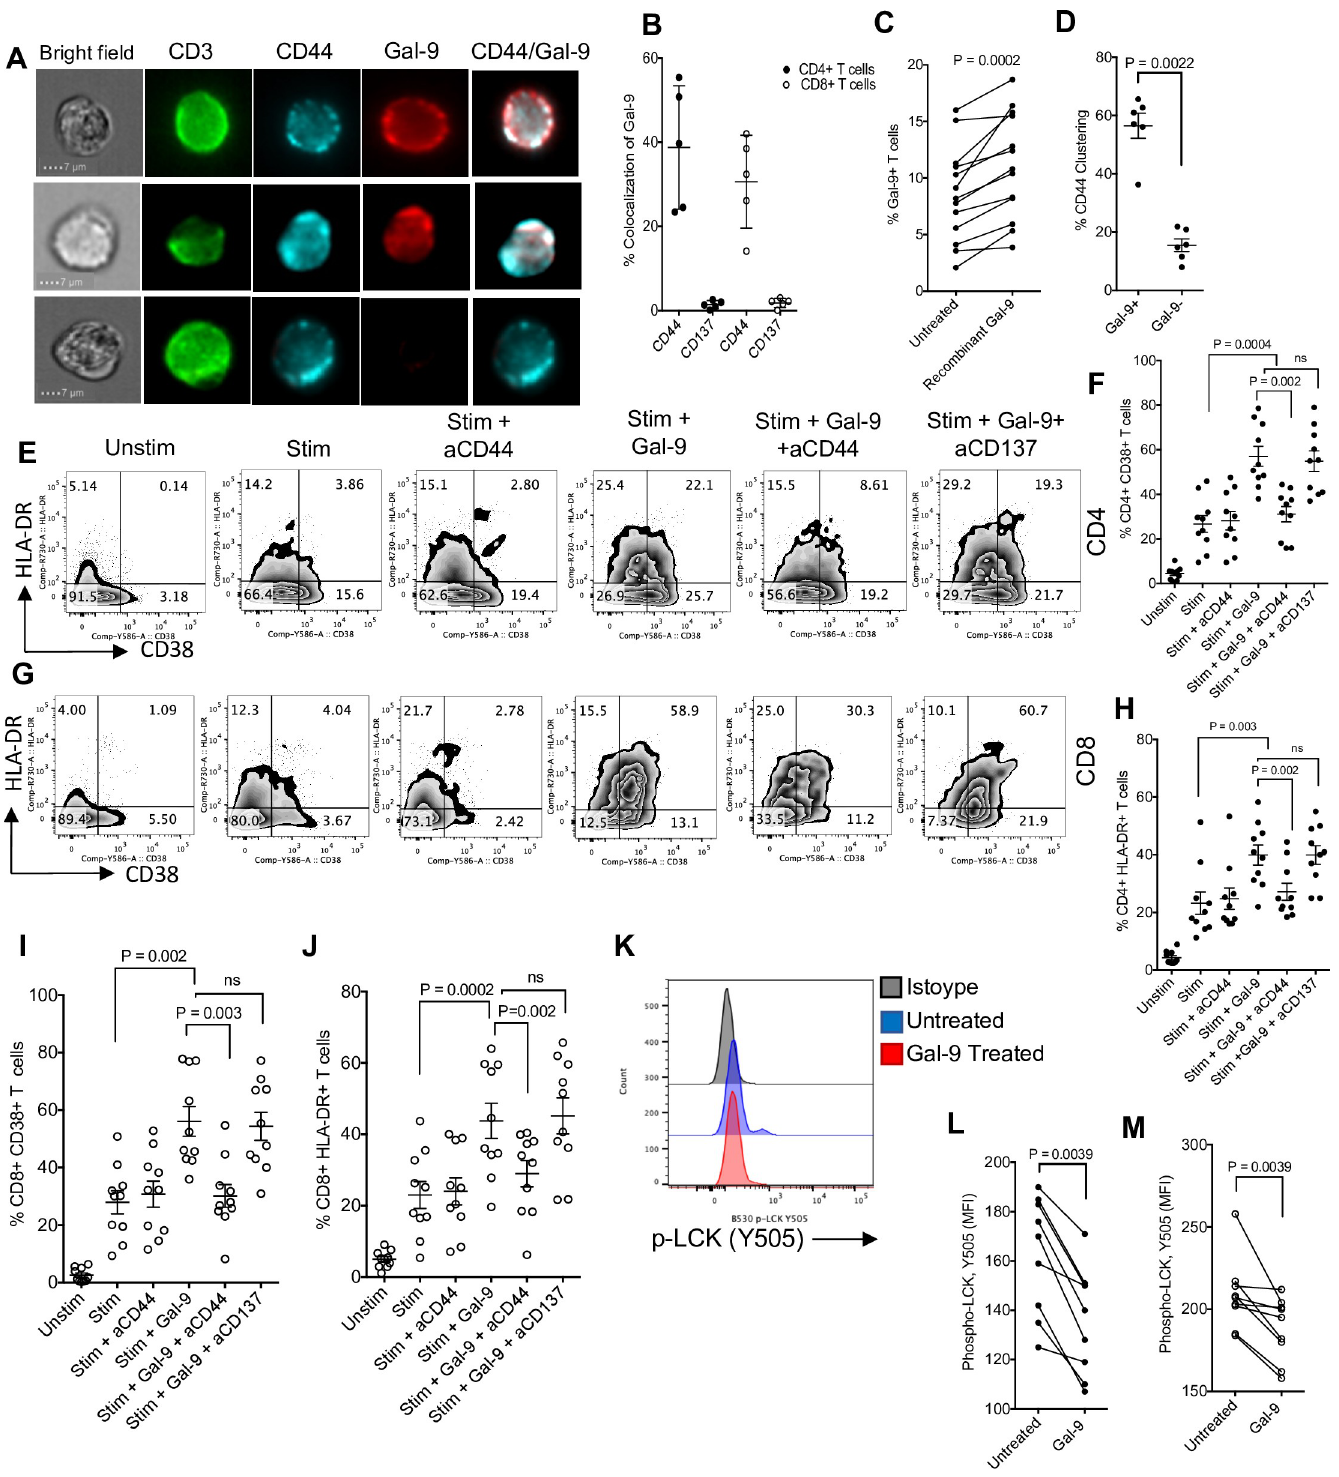
Fig 5. Gal-9 binds CD44 on T cells and enhances T-cell activation. (A) Images showing the expression of CD44 and Gal-9 on the surface of T cells. (B) Cumulative data showing percent colocalization of Gal-9 with CD44 and CD137. (C) Percent of Gal-9+ T cells in the presence or absence of recombinant Gal-9 following in vitro incubation. (D) Percent CD44 clustering in the presence and absence of Gal-9. (E) Representative plots and ( F ) cumulative data showing percentages of CD4 + T cells expressing CD38 or (G) HLA-DR following stimulation with anti-CD3/CD28 antibodies in the presence of exogenous Gal-9 (1,000 pg/ml) and/or Gal-9 and anti-CD44